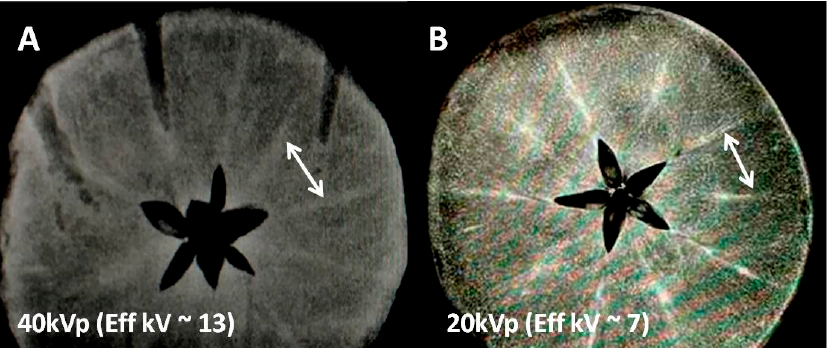
Figure 1. X-ray images of the mineral-rich apple at two different X-ray energies showing mineral conspicuity as a function of mean X-ray energy. ( A ) Non-contrast X-ray image at 40 kVp/10 mAs (with mean energy approx. 13 keV) using a clinical scanner; two typical high attenuation tracks marked by a white arrow indicate either K or Fe concentrated regions (Table 1). ( B ) Another apple slice showing the same mineral tracks at higher mineral conspicuity presumably due to lower kVp (soft) mammographic X-ray beam (20 kVp/10 mAs with mean energy approx 7 keV, close to k-edges of transition metal ions but far from k-edge of K ions, Table